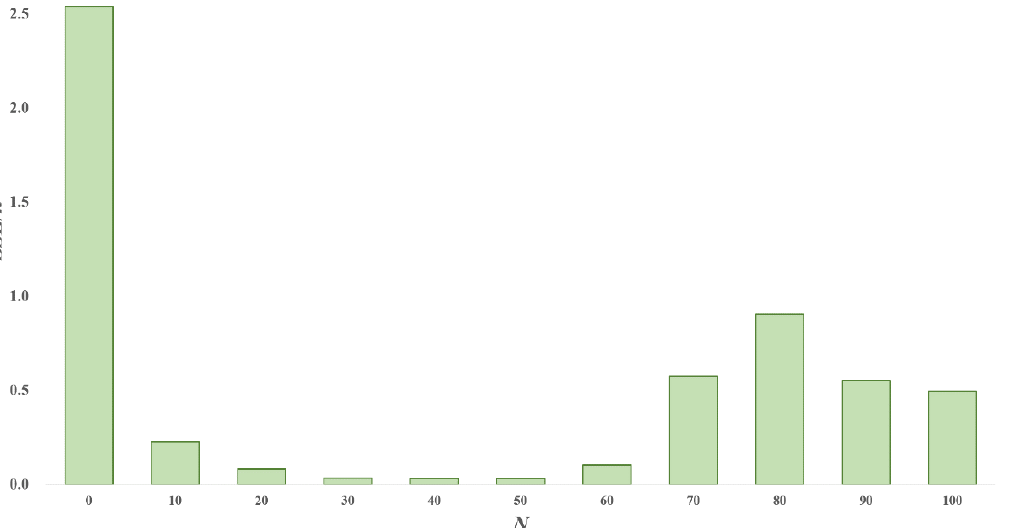
Figure 10. Mean square error (MSE) for different averaging windows.